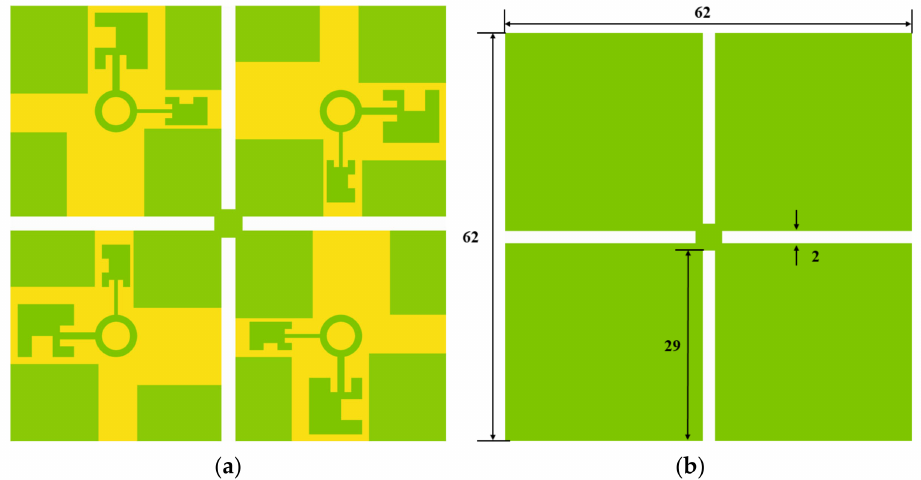
Figure 6. Quad-port pentaband antenna, ( a ) top and ( b )